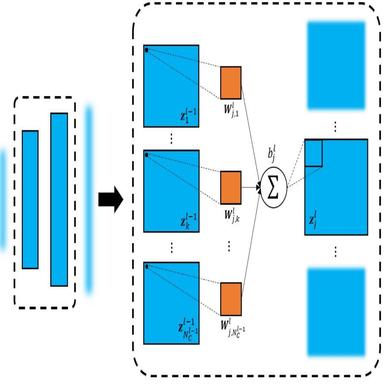
Building block of the transposed convolutional neural network in RVE-net.